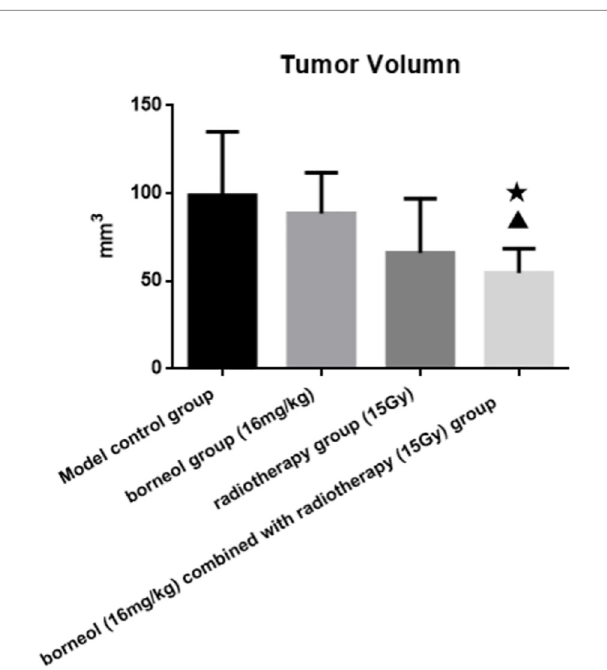
FIGURE 1 | Tumor volume of brain glioma in rats after borneol and radiotherapy treatment( (cid:1) x ± S, n=6). Compared with the control group, ▲ P<0.05; Compared with borneol group, ★